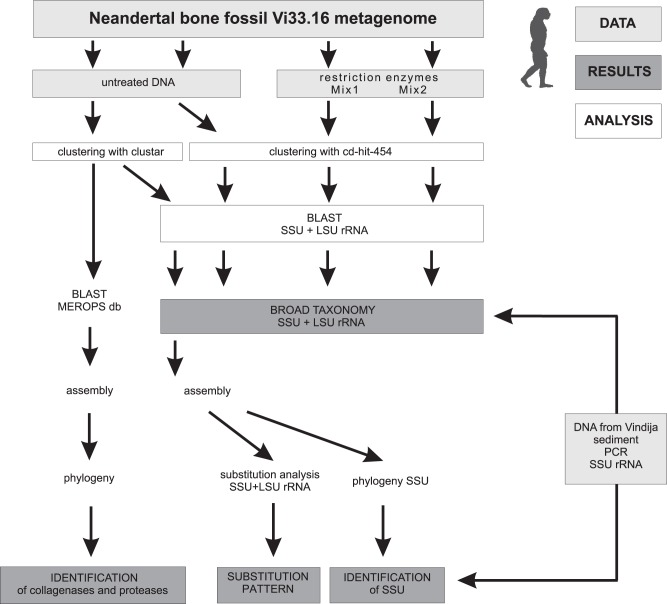
Schematic overview of the analysis workflow.